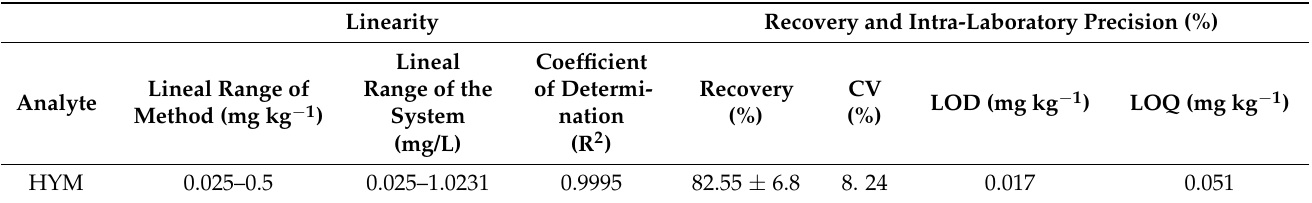
Table 2. Linearity, % recovery and LOD/LOQ of the method.